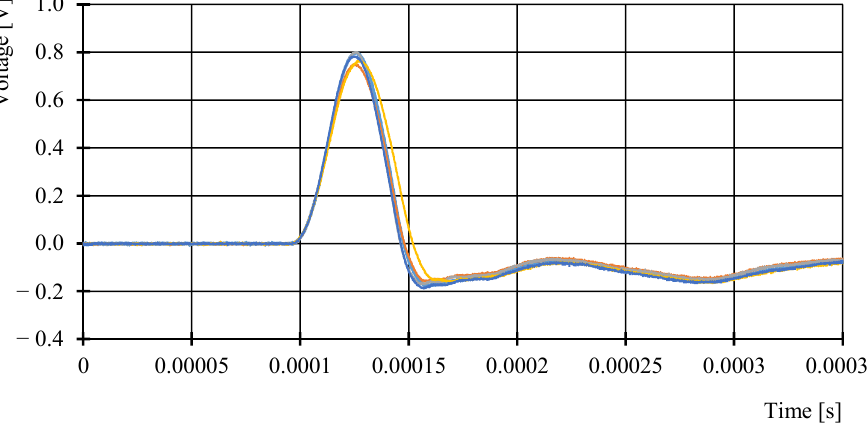
Figure 7. Examples of five measured signals for the home-made sensor 12 × 30 mm, ball mass 0.700 g and the initial ball height 150 mm.